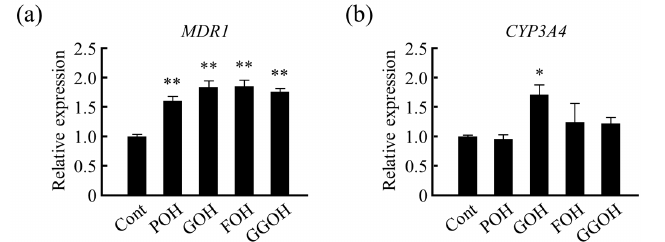
Figure 5. Effects of isoprenoid side chain structures on drug metabolism-related gene expression. ( a ) MDR1 and ( b ) CYP3A4 mRNA levels were measured using quantitative RT-PCR after 24 h of treatment with different types of isoprenoid structures. Relative mRNA levels were normalized to that of eukaryotic translation elongation factor 1 α 1 mRNA. Data are expressed as the mean ± standard error of the mean, n = 3, * p < 0.05, ** p < 0.01 vs. control (Cont). MDR1 , multi-drug resistance; CYP3A4 , cytochrome P450 3A subfamily 4; POH, phytol; GOH, geraniol; FOH, farnesol; GGOH, geranyl geraniol.